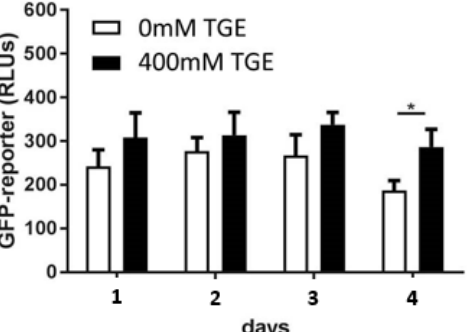
Figure 1. GFP-reporter for glutathione-S-transferase 4 expression after exposure to transient high glucose over indicated time-periods (day one, two, three, or four) and subsequent conduction of the experiment without TGE exposure for the same time period (measurement after a total of two, four, six, and eight days) to assess the persisting gst-4 exposure. In each experimental group the mean and standard deviation of three individual experiments is displayed with * p < 0.05.